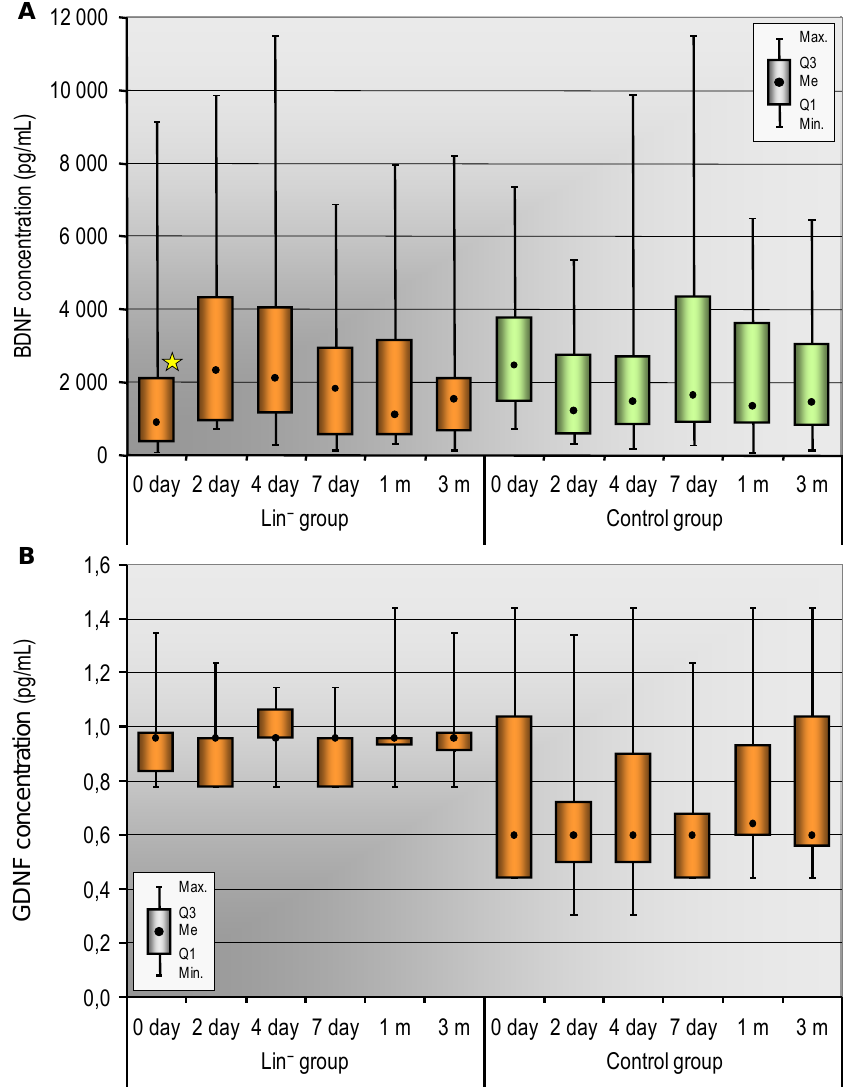
Figure 1. ( A ) The plasma levels of BDNF in the Lin − group and in the control group (day 0, 2, 4, and 7 and in month 1 and 3); m: month. Data are presented as median (lower – upper quartile). * p < 0.05 for BDNF concentration in the Lin – group vs. control group on day 0 (Mann – Whitney U-test). ( B ) The plasma levels of GDNF in Lin − group and in the control group (day 0, 2, 4, and 7 and in month 1 and 3). Data are presented as medians (lower – upper quartiles).